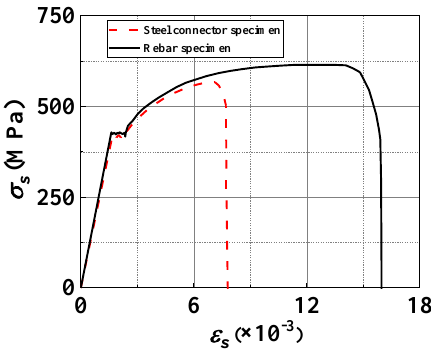
Figure 5. The stress – strain curve of the specimens with or without steel connector. (The red dotted line is the steel connector specimen, and the black solid line is the rebar specimen)